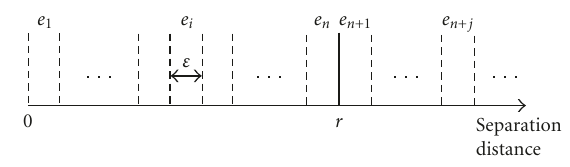
Figure 1: Depiction of state space for distance between a pair of nodes in the intermittent metric group, where communication links for nodes which move outside the transmission range, and back in again, are considered to be the “same”